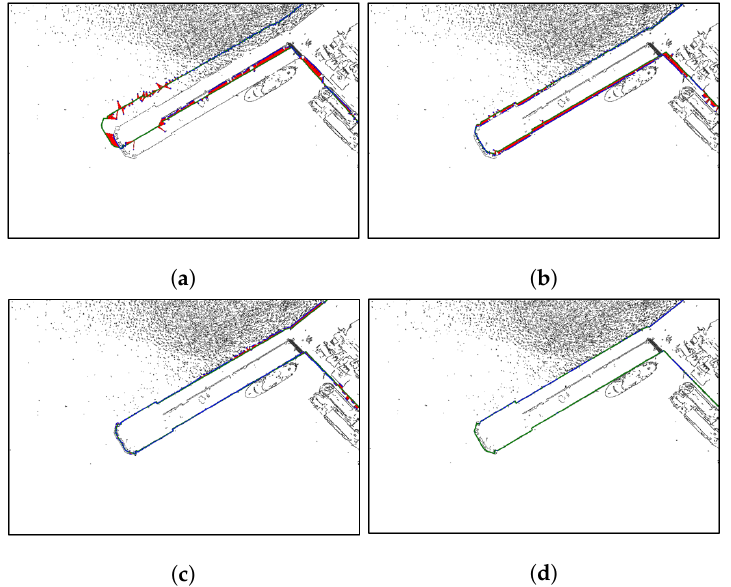
Figure 10. The processed image No. 1 with the boundary of the land area marked based on the ENC: ( a ) Iteration No. 1, ( b ) Iteration No. 2, ( c ) Iteration No. 3, ( d ) Iteration No.